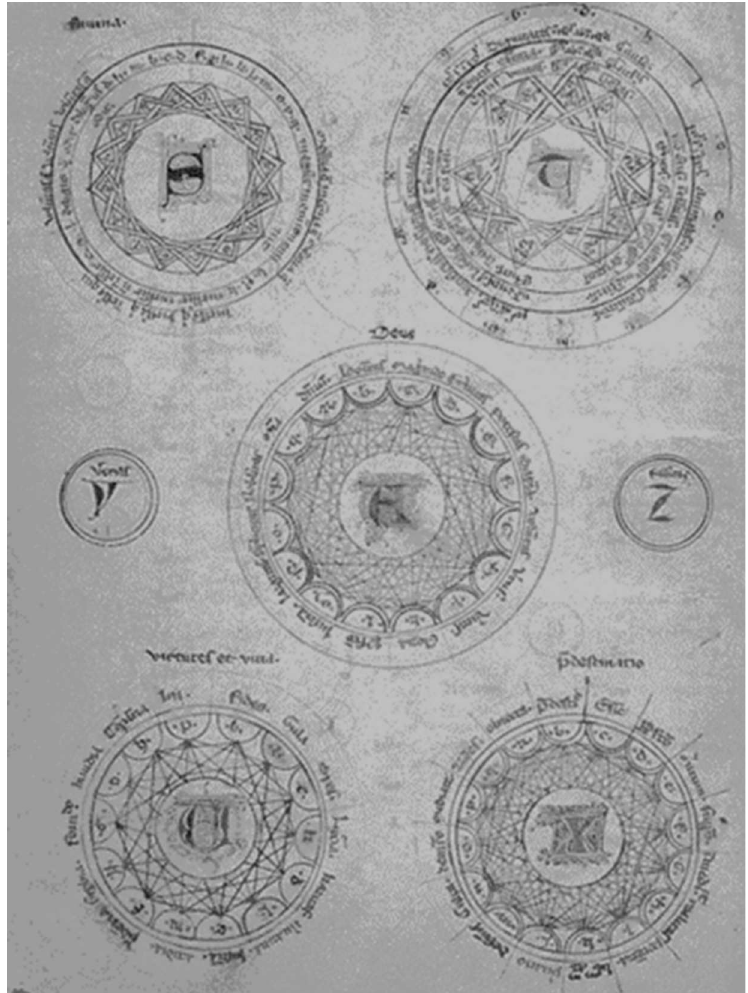
Figure 4. The machinery of the Art from the Ars demonstrativa. Source: manuscript VI 200, Biblioteca Marciana in Venice